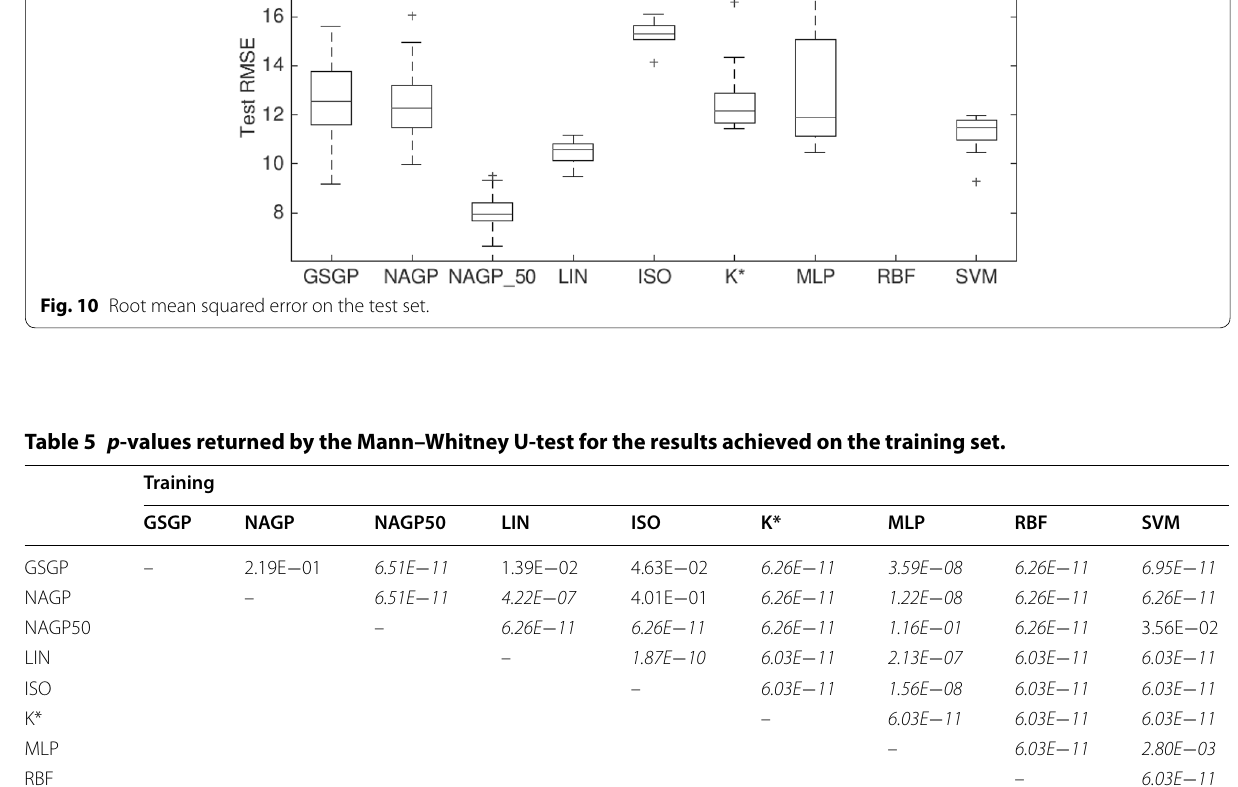
Italic is used to denote statistically significant differences between the considered techniques.